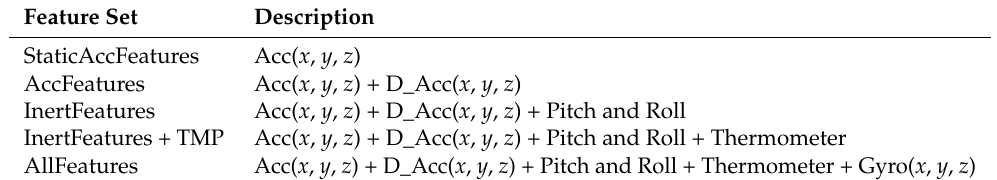
Table 5 . Feature set used. Table 5. Feature set used.